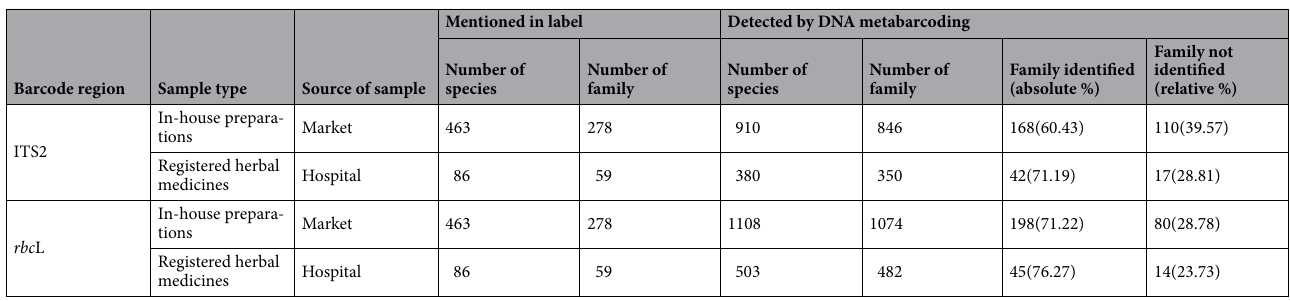
Table 3. Family verification according to sample type using DNA